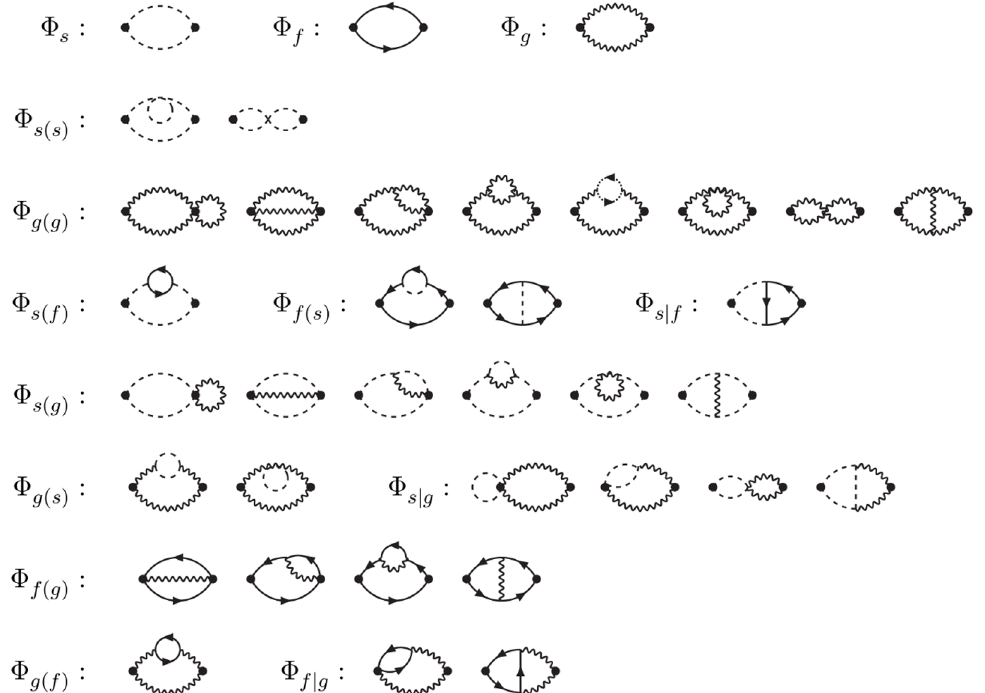
Figure 1 . The 1 and 2-loop graphs contributing to eq. (2.8). Each subset is gauge independent. Dashed lines denote scalars; solid lines fermions; wiggly lines gauge (cid:12)elds; dotted lines ghosts;